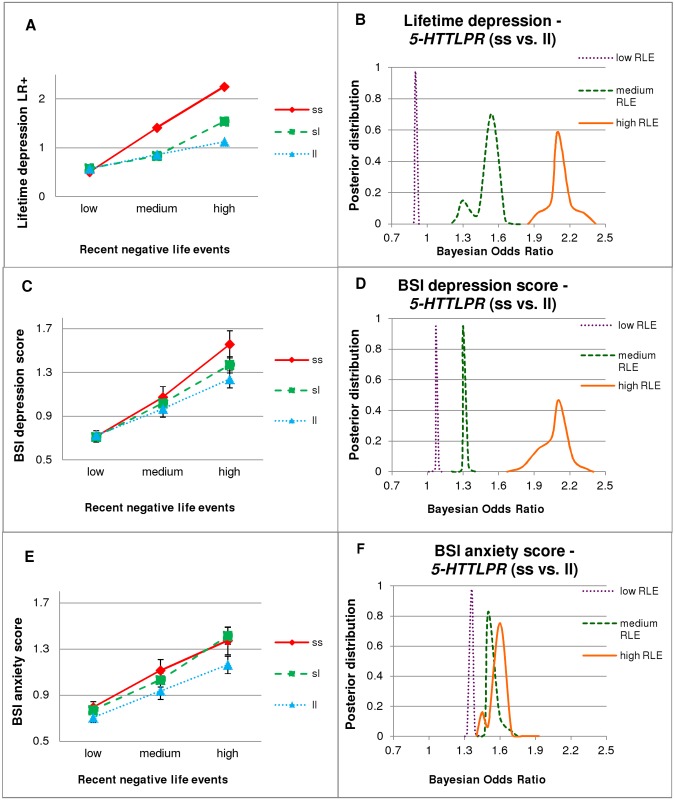

5-HTTLPRxRLE interaction, with PLINK (left column) and Bayesian (right column) analyses.LR+: likelihood ratio of emergence of the disease; BSI: Brief Symptom Inventory; BSI-DEP: BSI depression score; BSI-ANX: BSI anxiety score; DEP: lifetime depression; RLE: recent negative life events (in the last year). The three categories of RLE are: low = 0–1, medium = 2, high = 3 or more. Numbers in groups: low RLE: ss = 292, sl = 746, ll = 480; medium RLE: ss = 82, sl = 207, ll = 144; high RLE: ss = 51, sl = 146, ll = 134. Standard errors of means are displayed in case of continuous variables (left column). Right column figures display outlines of posterior distributions of Bayesian Odds Ratios of 5-HTTLPR ss versus ll genotype with respect to DEP, BSI-DEP (severe vs. low), and BSI-ANX (severe vs. low). Subsets according to RLE categories (low, medium and high) were analyzed individually. Curve flatness refers to the number of possible models, each with a different odds ratio. An odds ratio greater than one represents a risk for the given phenotype. 1A. Logistic regression analysis showed that having the more s alleles increased the risk of DEP with increasing number of RLE. 1B. Regarding DEP there is a clear difference between subjects with low RLE (with a Bayesian Odds Ratio close to 1) and subjects with medium or high RLE (where the effect of ss genotype is stronger). 1C. As in case of DEP: having the more s alleles also increased BSI-DEP with increasing number of RLE, using linear regression analysis. 1D. As in case of DEP: effect of ss genotype on BSI-DEP is negligible in the low RLE group, but higher in the medium, and especially high in the high RLE group. 1E. In contrast to depression phenotypes: linear regression analysis showed that carrying the more s alleles increased BSI-ANX without interaction with RLE. 1F. In contrast to depression phenotypes, ss genotype represents a risk for BSI-ANX irrespective of RLE group.